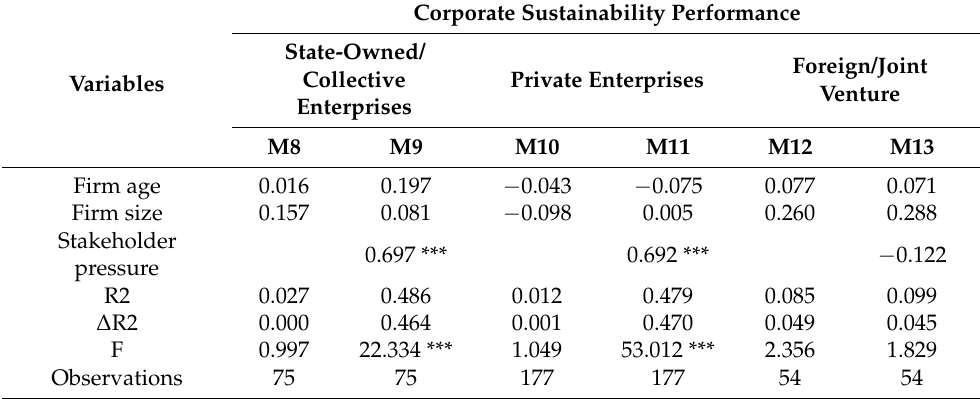
Table 5. The results of grouping main hypothesis test for different firm